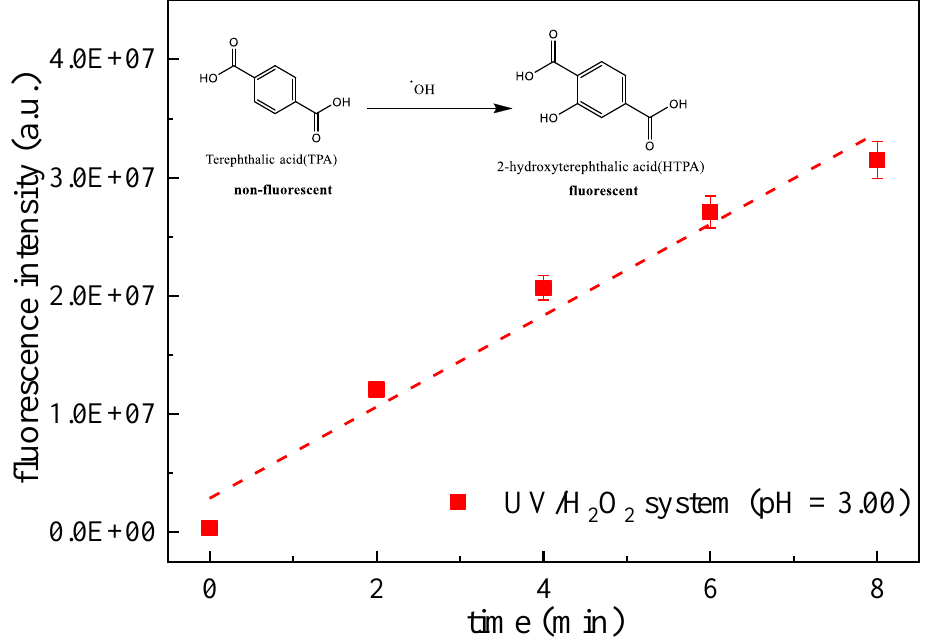
Figure 5. Fluorescence signal intensity of HTPA over time. ([TPA] = 100 μM , [H 2 O 2 ] = 100 μM , and I 0 = 7.50 × 10 − 6 Einstein L − 1 s − 1 .)